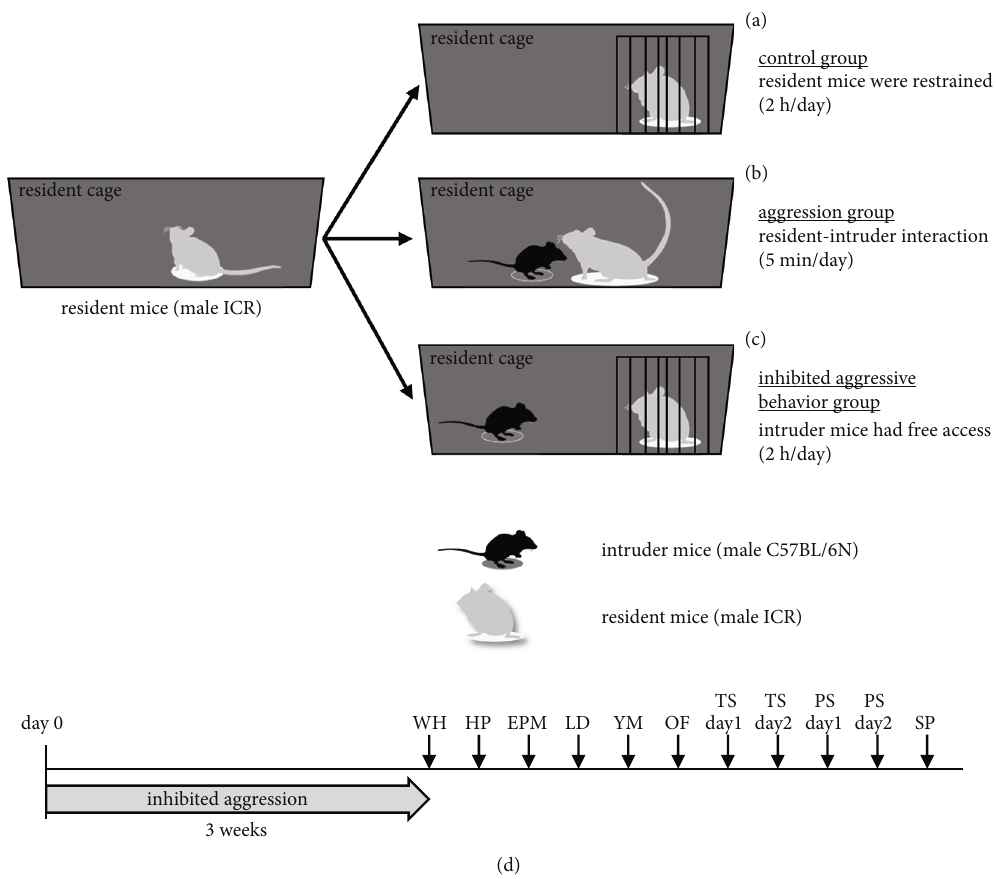
Figure 1: Schematic of the experimental design and time schedules. (a) Control group: a resident ICR mouse is placed into one of the wire cages ( 7 : 5 × 7 : 5 × 10 cm; vertical bars, 0.5 cm apart) that were located in the corners of home cage for 2 hours per day. (b) Aggression group: C57BL/6N mice of the experimental group are placed as intruders in the ICR mouse cages for 5 minutes per day. During the contact process, C57BL/6N mice were attacked by ICR mice, exhibiting evasion, compliance, resistance, and other behaviors. The C57BL/6N mice were rotated daily for 3 weeks to ensure that every ICR mouse in the experimental group had the opportunity to show aggression to di ff erent intruders. (c) Inhibited aggressive behavior group: a resident mouse is placed into one of the wire cages that were located in the corners of home cage. The intruder C57BL/6N mice were placed in the ICR mouse cages for 2 hours per day. C57BL/6N mice were allowed to move freely in home cages with wire cages containing resident ICR mice. The C57BL/6N mice were rotated daily for 3 weeks to ensure that every ICR mouse in the experimental group experienced stress from di ff erent intruders. (d) Animals in the control, aggression, and inhibited aggressive behavior groups were subjected to tests once a day for 3 weeks. Afterwards, we performed the behavioral test battery. Mice were subjected to one behavioral test per day. ICR, Institute of Cancer Research; WH, wire hang test; HP, hot plate test; LD, light/dark transition test; YM, Y-maze test; TS, tail-suspension test; PS, Porsolt forced swim test; SP, sucrose preference